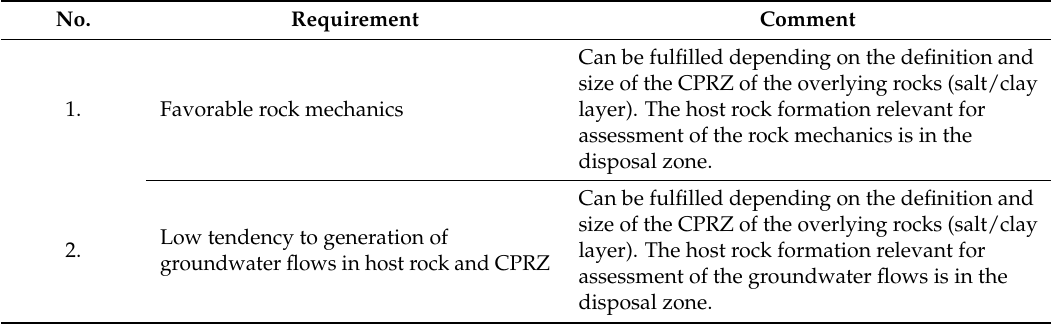
Table 3. Requirements of weighting group 2: Validation of